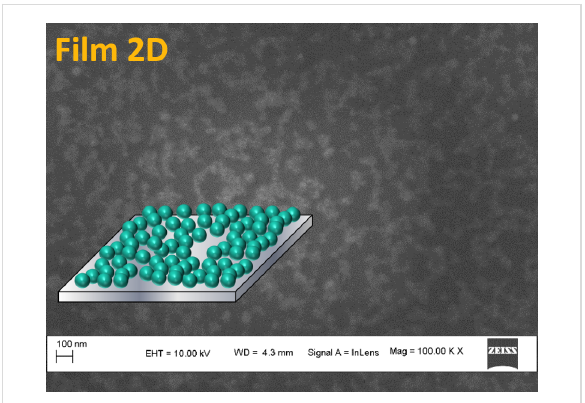
Figure 9: Thin films prepared by drop casting of a suspension of ENP- PMMA in